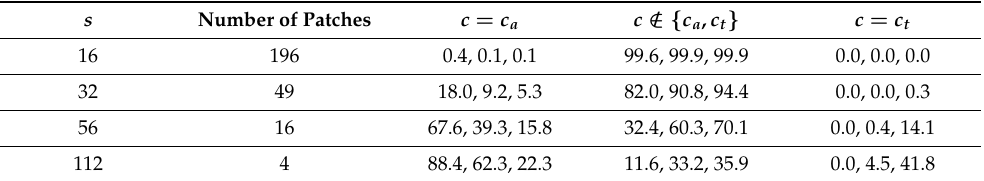
Table 2. Percentages of shuffled images sh ( A p q , s ) (first percentage), sh ( D EA age), and sh ( D BIM